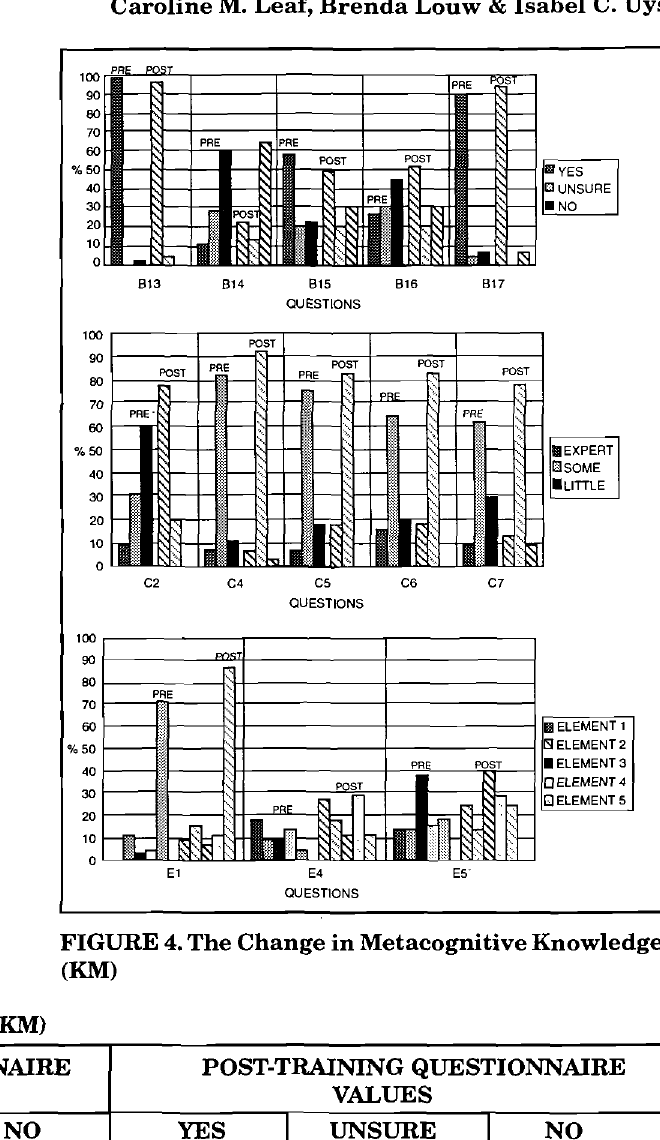
TABLE 3: The change in Metacognitive Knowledge (KM)